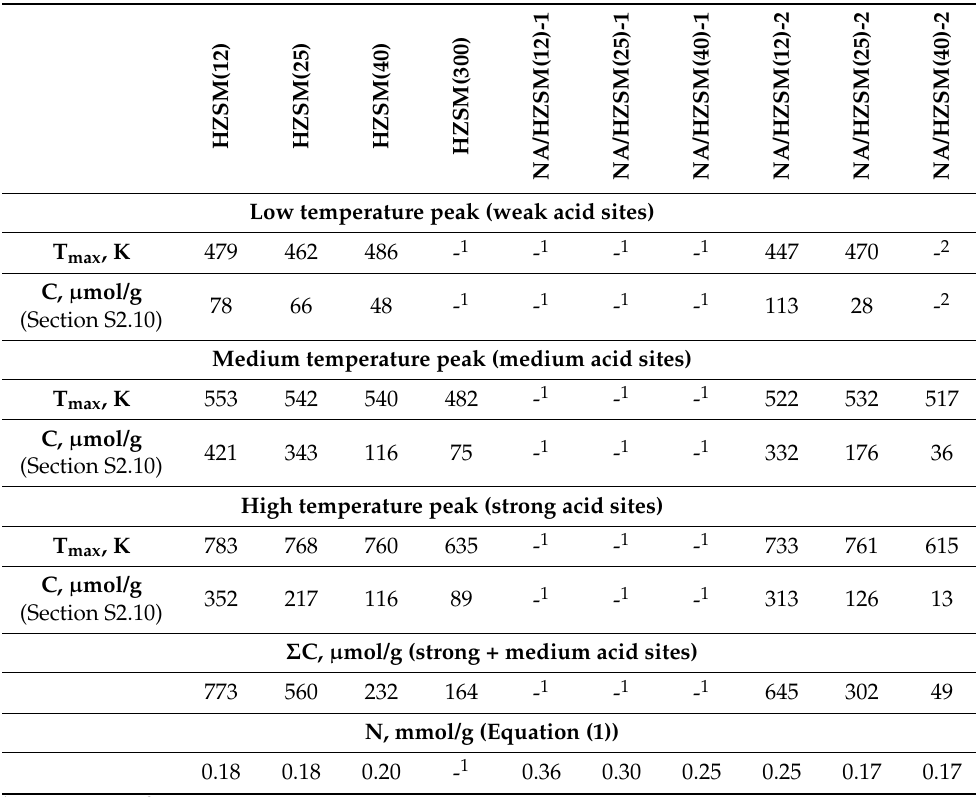
Table 9. Acidic properties of HZSM and NA/HZSM-2 samples (data from